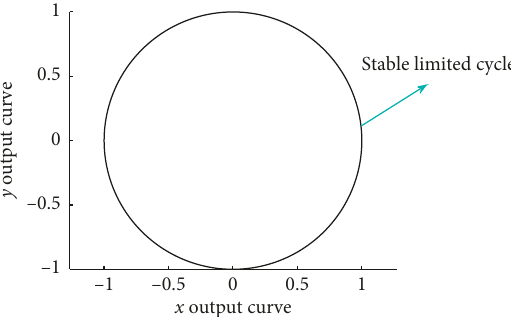
Stable limited cycle